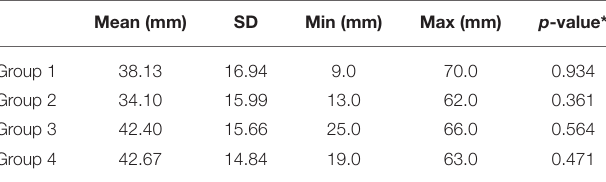
TABLE 3 | Size of the SAT lesions in the analyzed group of